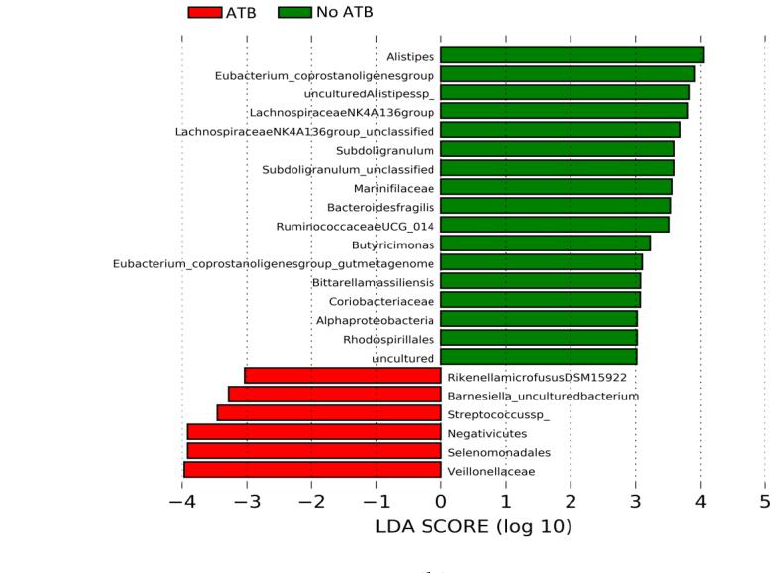
Figure 1. Stacked bar plot of the phylogenetic composition of the most common taxa at the genus level. Bacteroides , in dark blue, was the most frequent genera identified within the cohort.